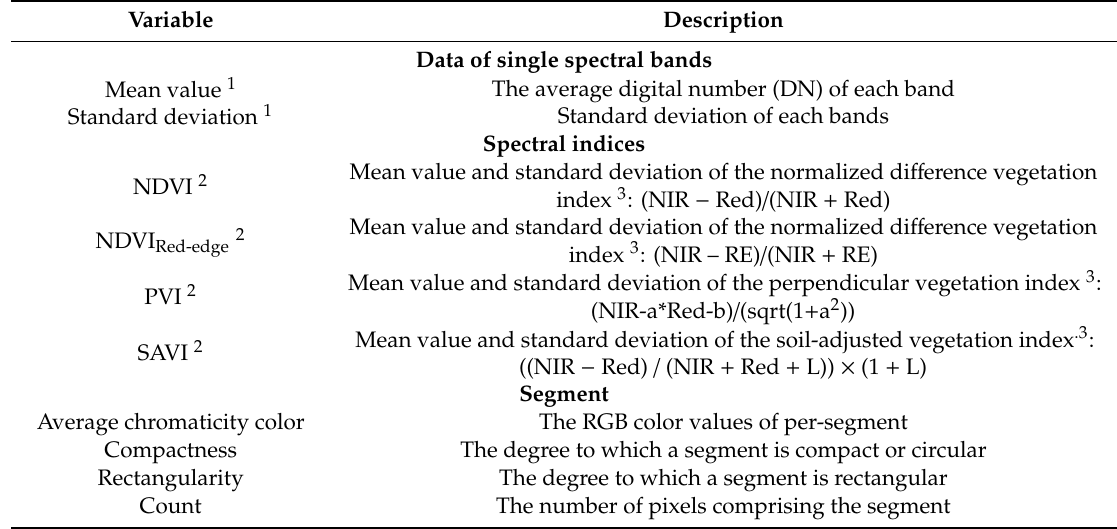
Table 2. Description of the predictor variables used in random forest (RF) classification. Note that each variable has been calculated for each segment and